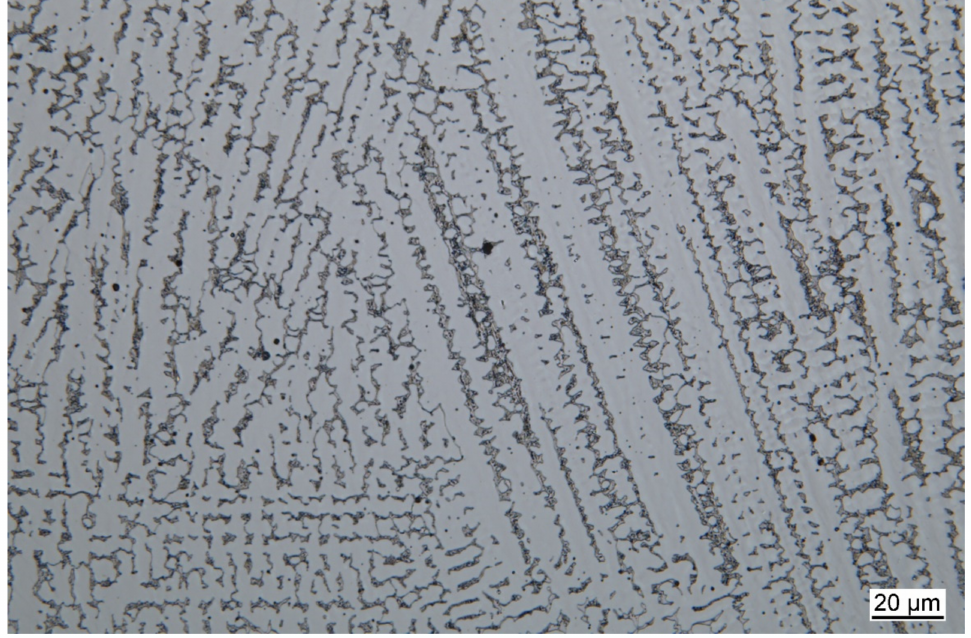
Figure 8. Etched with V2A mordant (magnification 500 ×